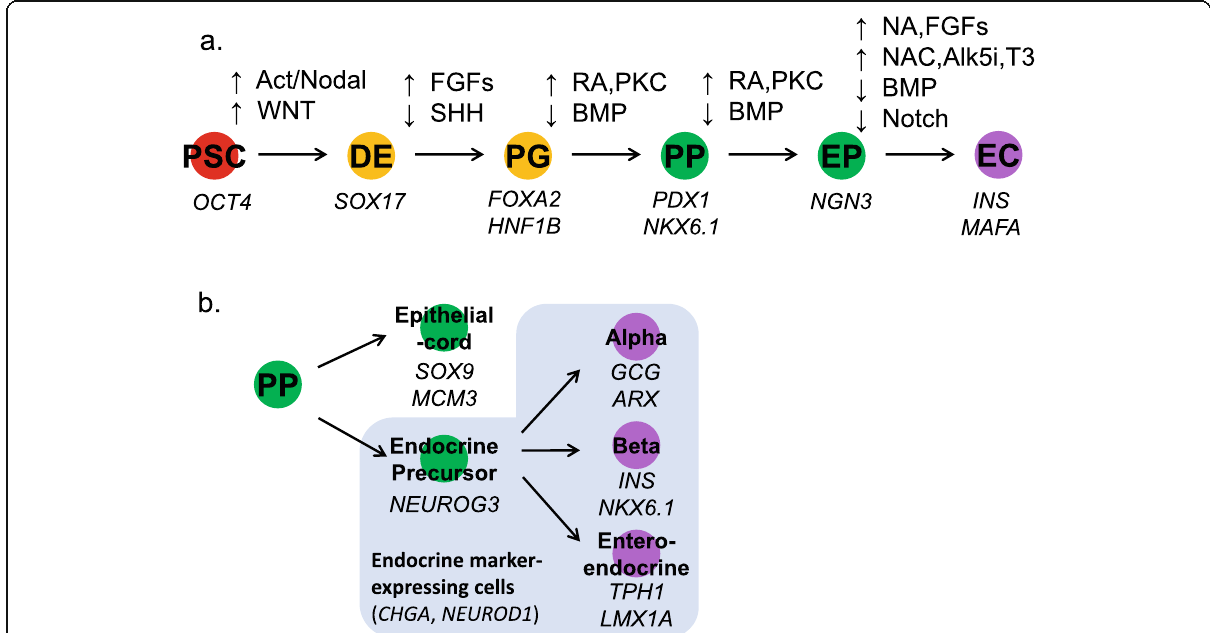
Fig. 1 Directed differentiation of PSCs into pancreatic beta cells. a The schematic diagram of directed differentiation into pancreatic beta cells using PSCs. PSCs are directed through 5 stages; each stage utilizes the inhibition ( ↓ ) or activation ( ↑ ) of various signaling pathways. Genes specifically expressed at each stage are shown. b Genes expressed in various cell groups revealed from scRNA-seq analysis. PSCs pluripotent stem cells, DE definitive endoderm, PG primitive gut tube, PP pancreatic progenitor, EP endocrine progenitor, EC endocrine cell, SHH sonic hedgehog, FGFs fibroblast growth factors, BMP bone morphogenic protein, RA retinoic acid, PKC protein kinase C, NA Nicotinamide, NAC N -acetyl-cysteine, Alk5i transforming growth factor-beta receptor inhibitor, T3 thyroid